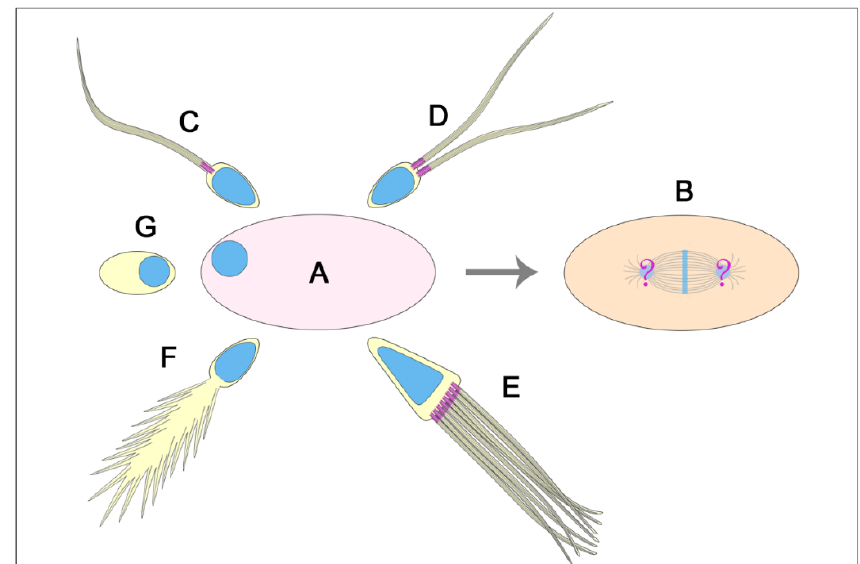
Figure 10. Centriole number in insect spermatids and fertilization problems. The insect egg ( A ) is activated during the transition through the oviduct, but the development in dioic species requires the contribution of the male gamete to assemble the first zygotic spindle ( B ). This process is obvious when the sperm have only one centriole (and eventually an atypical centriole) (most of the insects, ( C ). However, this aspect is less clear when the sperm carry two functional centrioles (Mallophaga and Anoplura, ( D ) or multiple centrioles ( Mastotermes , ( E ) since in this case the egg is forced to elaborate mechanisms to avoid polyspermy. By contrast, the spermatids with giant axonemes consisting of large cytoplasmic bundles of microtubules, but with modified centrioles (i.e., several gall-midges), ( F ) or aflagellate sperm without centrioles (as in some white flies), ( G ) raise the question of how the egg cytoplasm can assemble the first centrosome without obvious male contribution.